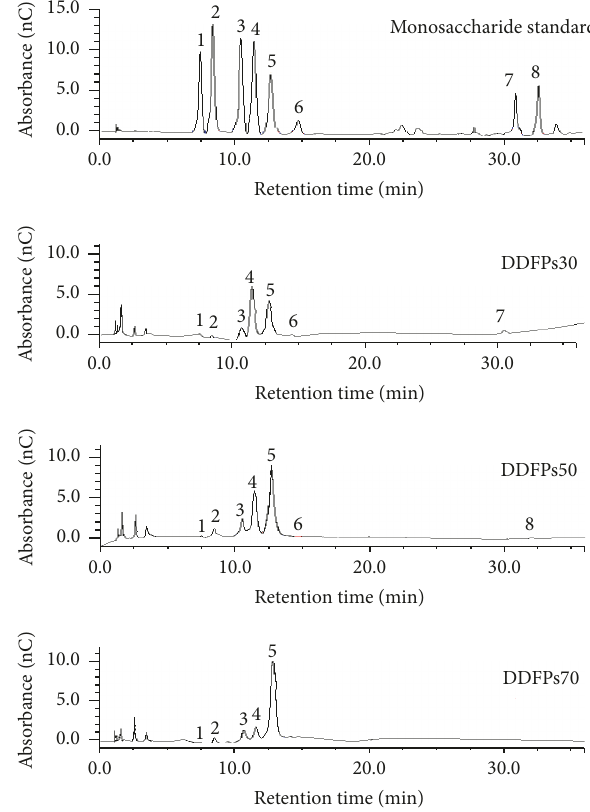
Figure 4: HPAEC-PAD analysis profiles of monosaccharide composition in three fractions from DDFPs. Each peak was separated as described as 1: 𝛼 -L-rhamnose, 2: L-arabinose, 3: galactose, 4: glucose, 5: mannose, 6: fructose, 7: galacturonic acid, and 8: glucuronic